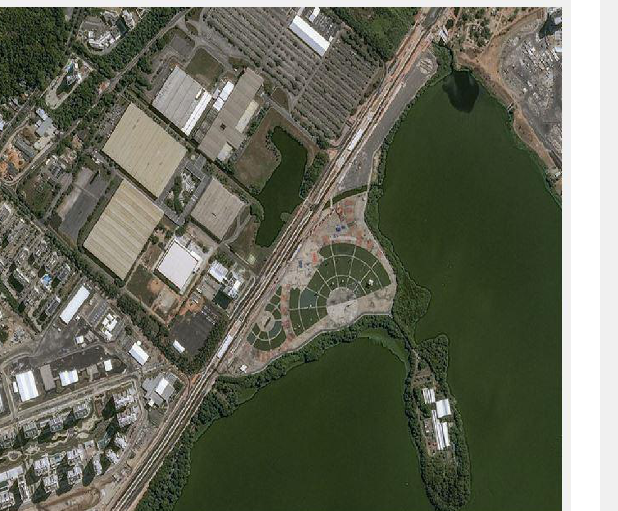
Figure 7. Original Image